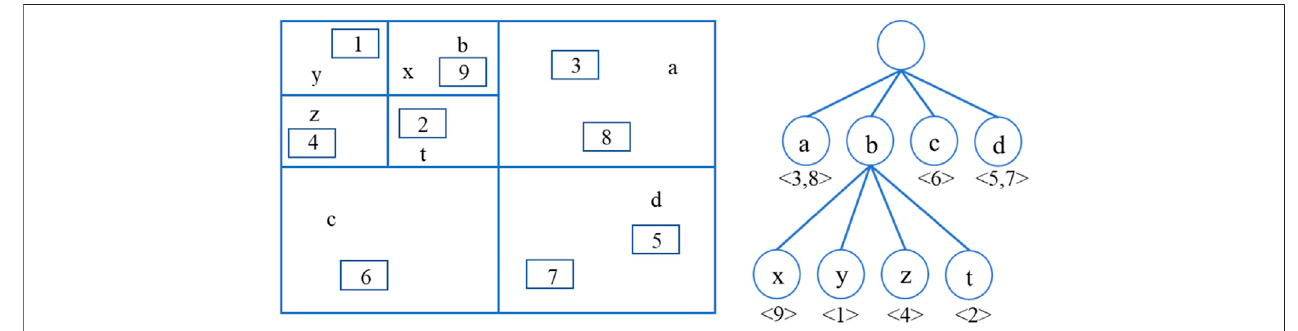
FIGURE 9 | The principle of the quadtree spatial index.